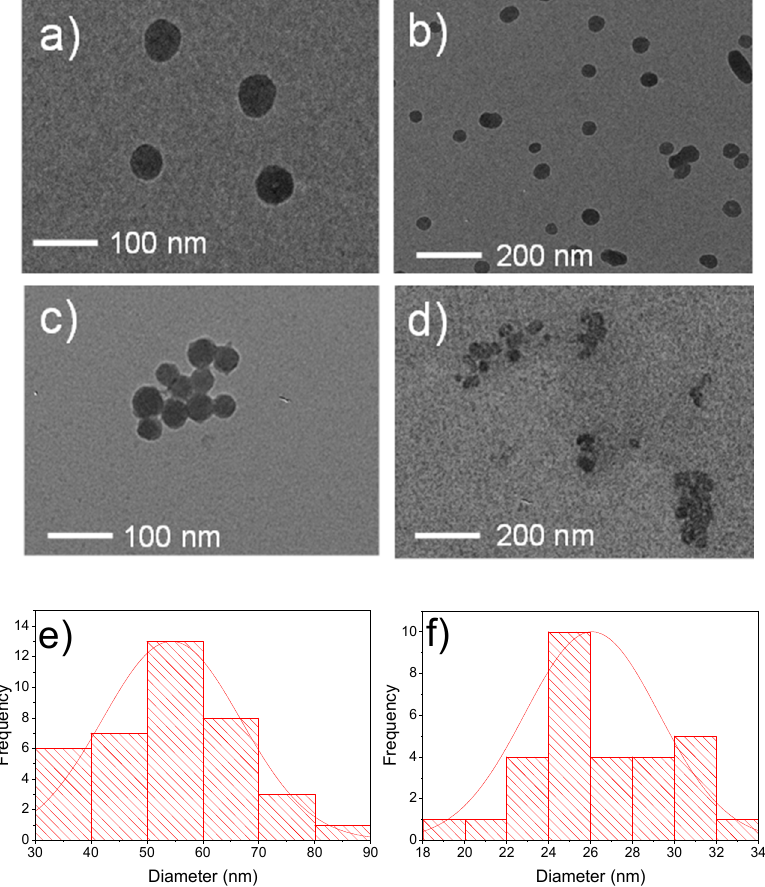
Figure 1. TEM images of the calcium oxide nanoparticles obtained by different routes: ( a , b ) CaO nanoparticles ca. 55 nm diameter, ( c , d ) CaO nanoparticles ca. 25 nm diameter. Histograms of TEM images of: ( e ) CaO nanoparticles ca. 55 nm diameter and ( f ) CaO nanoparticles ca. 25 nm diameter.